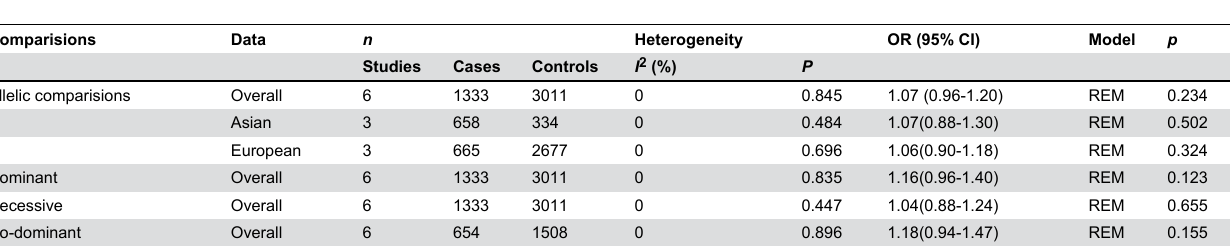
Table 2. Pooled measures for the association between the PAI-1 -675 4G/5G polymorphism and susceptibility to diabetes.